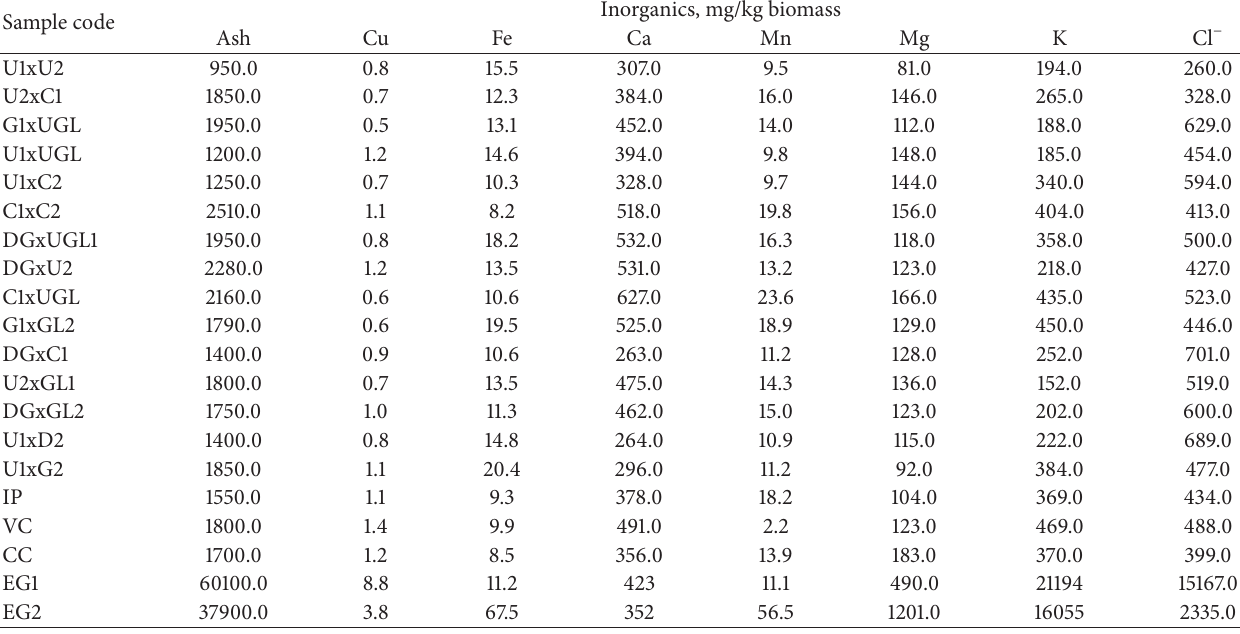
Table 5: Ash and metal content of the eucalypt clones evaluated.